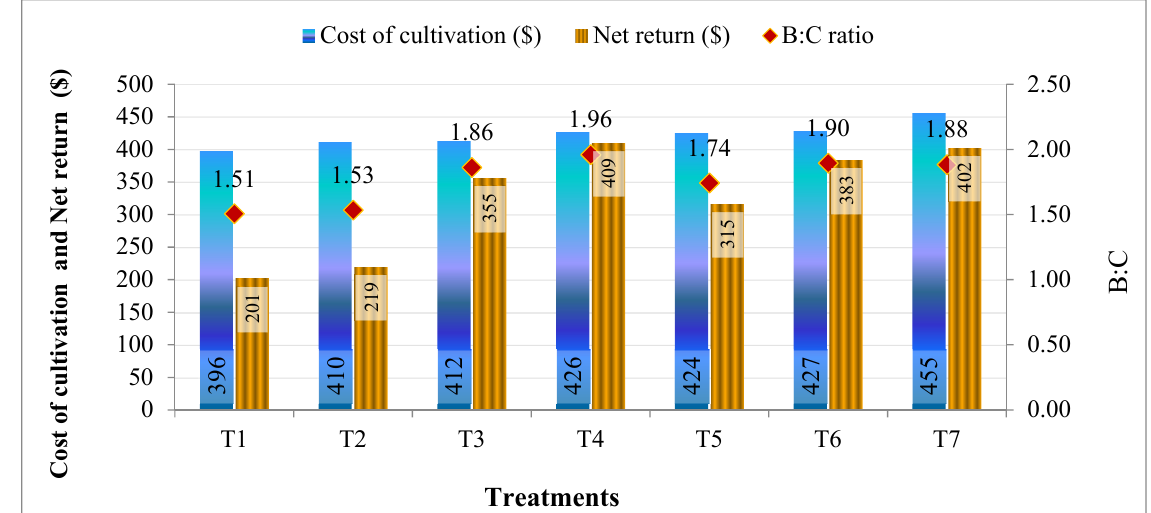
Figure 2. Effect of Zn and Fe biofortification on cost of cultivation, net returns and economic analysis of lentil. Treatment details are available in Table 1.